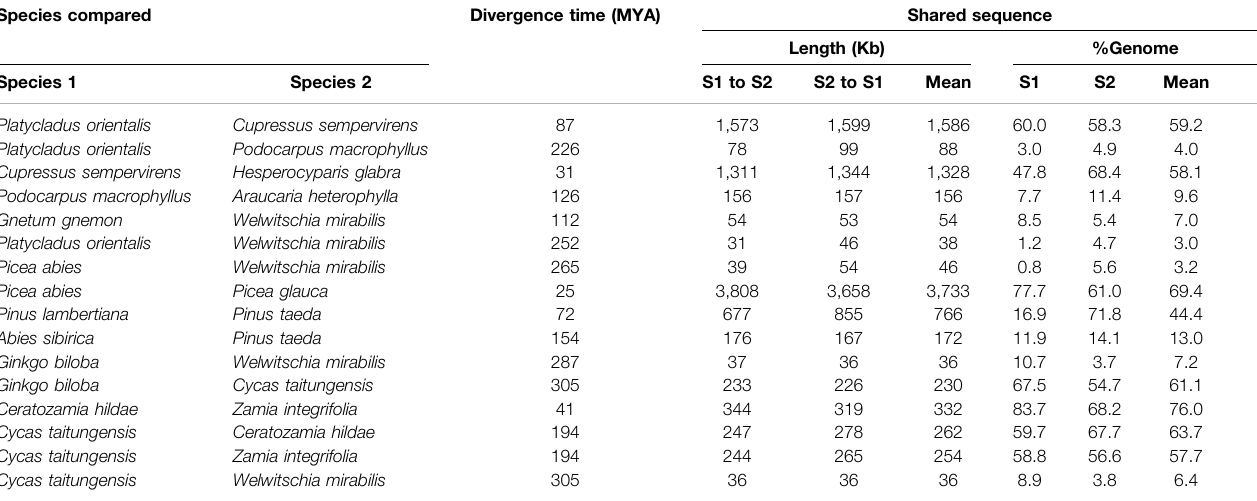
TABLE 4 | Amount of shared mitochondrial DNA in gymnosperms spanning a wide range of divergence times. MYA, million years ago. Species